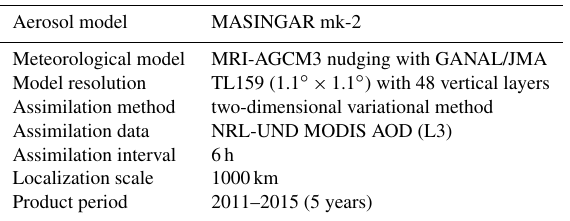
Table 1. Configuration of the reanalysis.